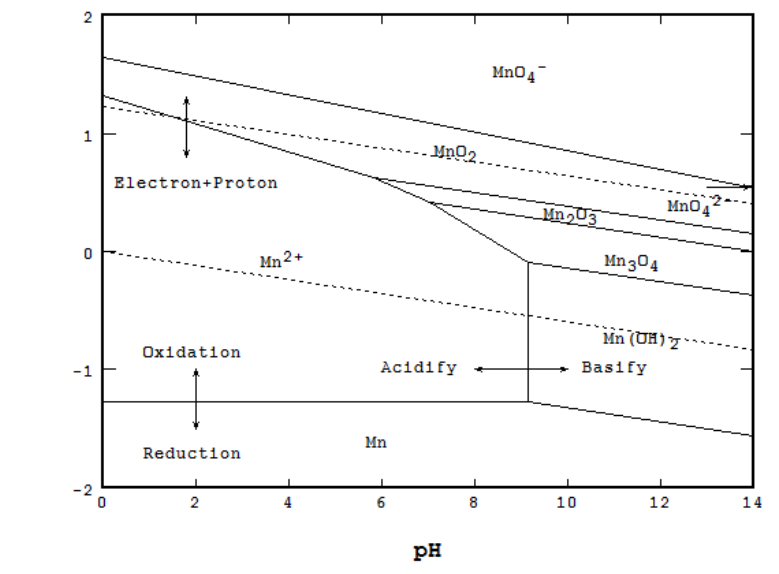
Figure 1. Eh-pH diagram of a Mn–water system. Dissolved manganese concentration, [Mn] = 0.001 M.